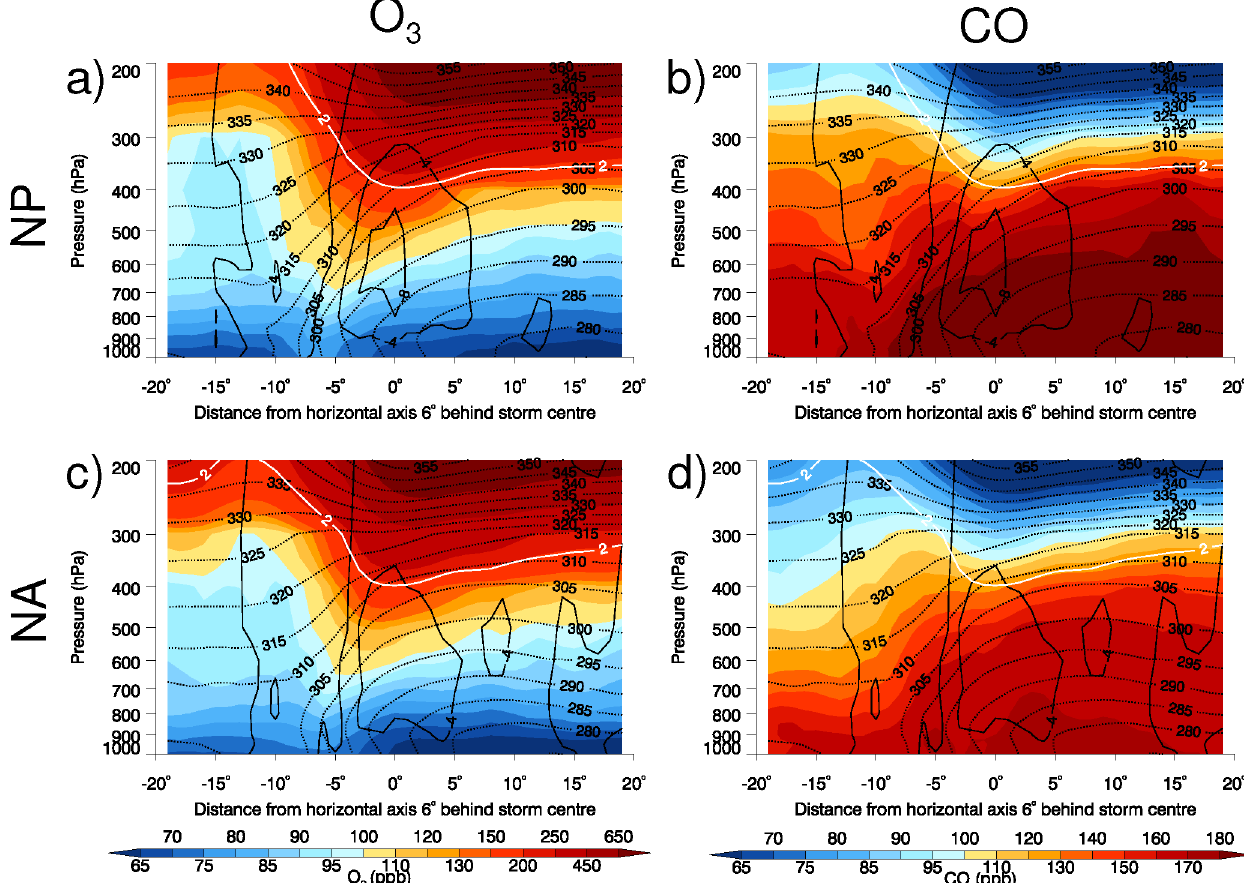
Figure 12. Vertical cross sections of the horizontal composite for (a, c) NP and (b, d) NA 95th percentile MAM storm tracks during 2003– 2012 for the DI, 6 ◦ to the left of the storm center. (a, c) O 3 and (b, d) CO (ppb) with θ e (dotted contour lines, 5K intervals), ω (solid contour lines; 4hPah − 1 contour intervals, with positive values indicating ascent), and the isosurface of 2 PVU (solid white line) are shown.